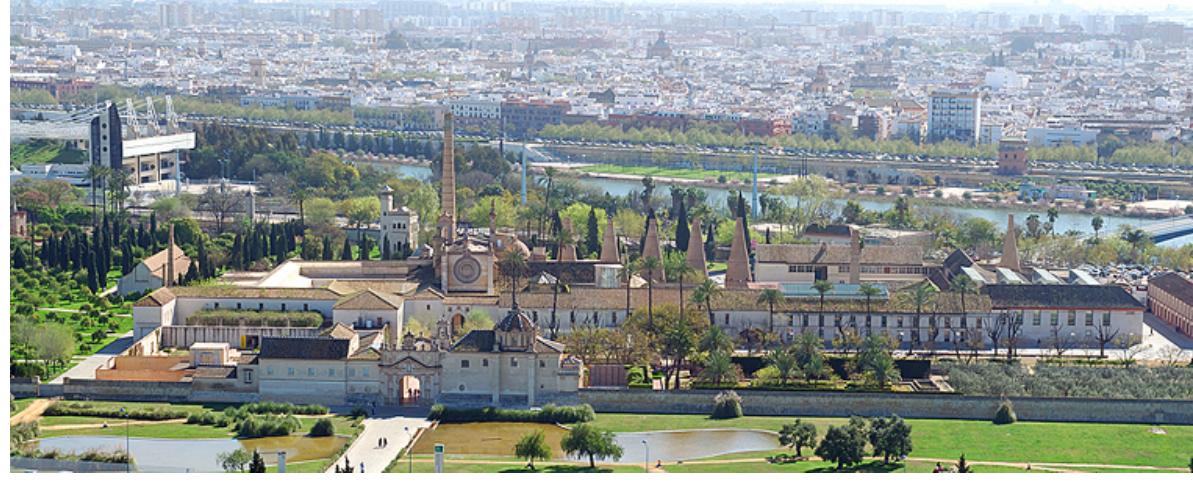
Figure 4: Current view of the monastery, headquarters of the IAPH, CAAC and IA University.